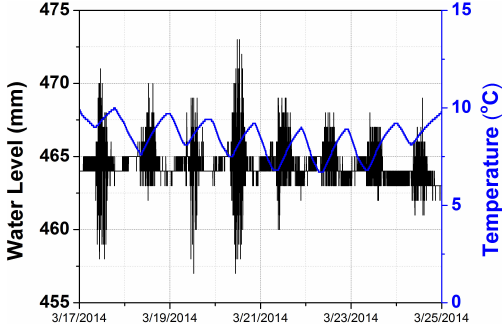
Figure 9. Water level and temperature readings during a 7-day pe- riod at the Santiam site on Oregon Highway 22.